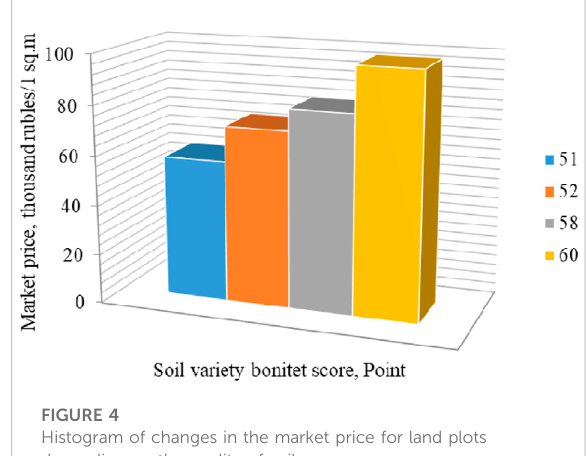
FIGURE 4 Histogram of changes in the market price for land plots depending on the quality of